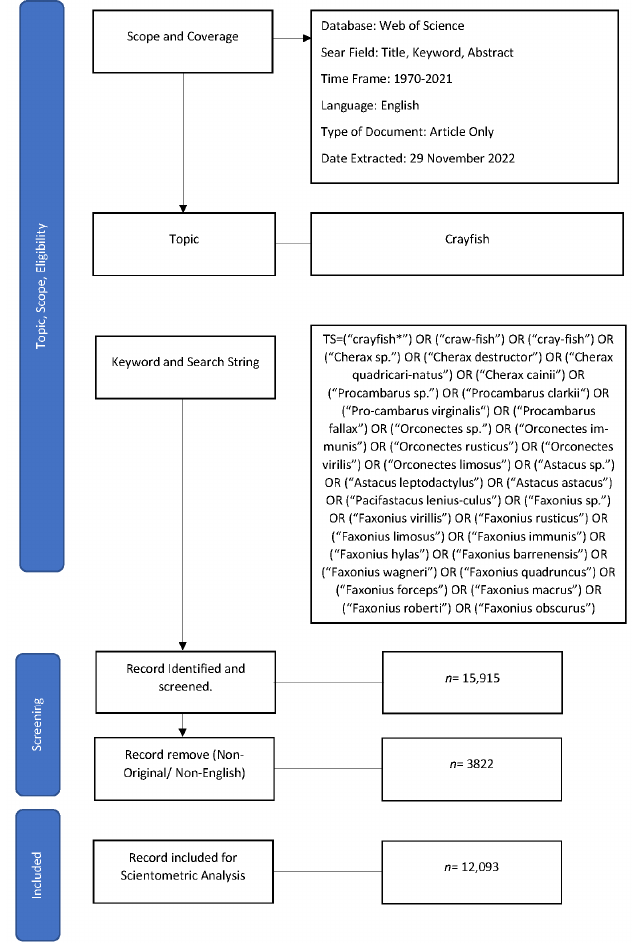
Figure 1. The research flow chart for the analysis of crayfish research around the world.